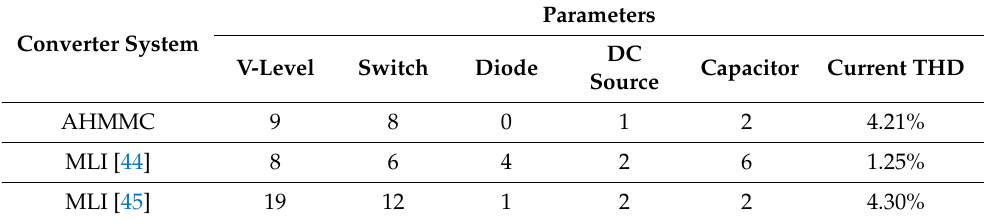
Table 6. Comparative analysis of converter